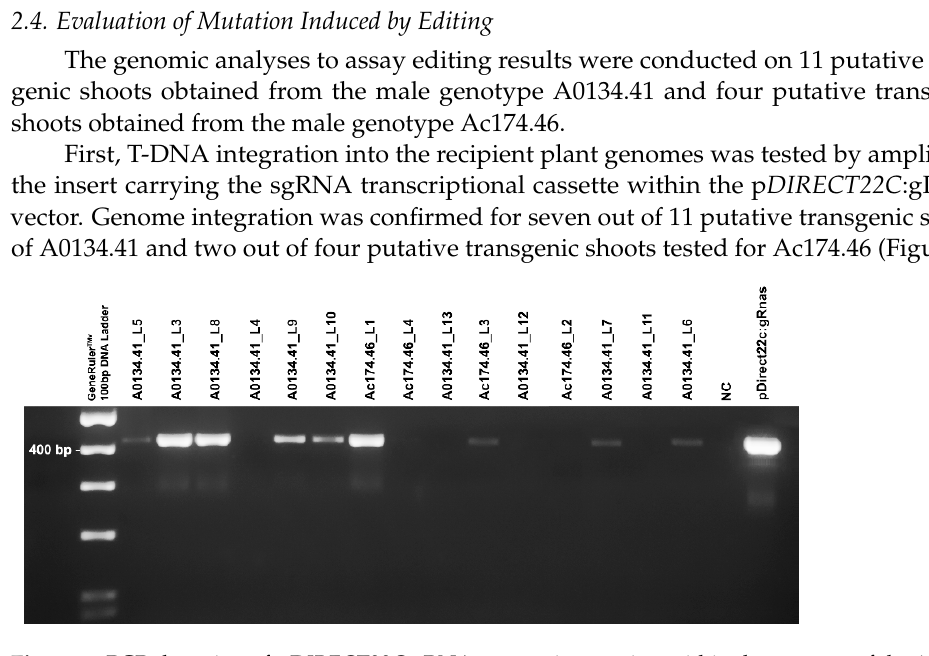
Figure 3. PCR detection of p DIRECT22C :gRNAs vector integration within the genome of the 11 putative transgenic shoots obtained for the male genotype A0134.41 and four putative transgenic shoots obtained for the Ac174.46 cultivar. The primer pair TC320/TC089R amplifies the p DIRECT22C :gRNA vector cassette where the two guideRNAs were cloned, producing a 418 bp fragment. GeneRuler TM 100 bp DNA Ladder (Thermo Fisher) was used for sizing the PCR products in the range of 100 to 1,000 bp on agarose gel. Plant line code of each putative transgenic shoot is reported. The last two samples represent the negative control (NC, Milli-Q water) and the positive control (the p DIRECT22C :gRNAs vector), respectively. Image for illustrative purpose. The original image is reported in Figure S3.